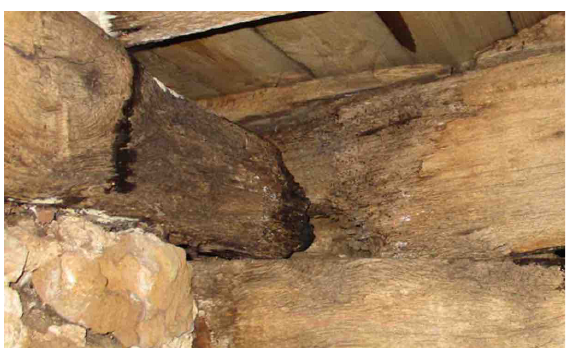
Figure 7 . Rot in the bottom of column